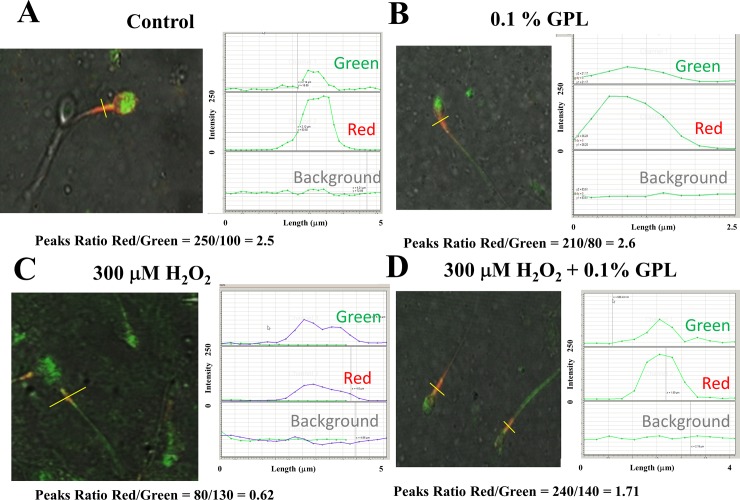
Confocal images of human sperm stained with JC-1 under different experimental conditions.(A) Live imaging of sperm incubated in control medium. (B) The same experiment as in A, but in the presence of 0.1% GPL. (C) Sperm incubated in 300 μM H2O2. (D) Sperm co-incubated with 300 μM H2O2 and 0.1% GPL.